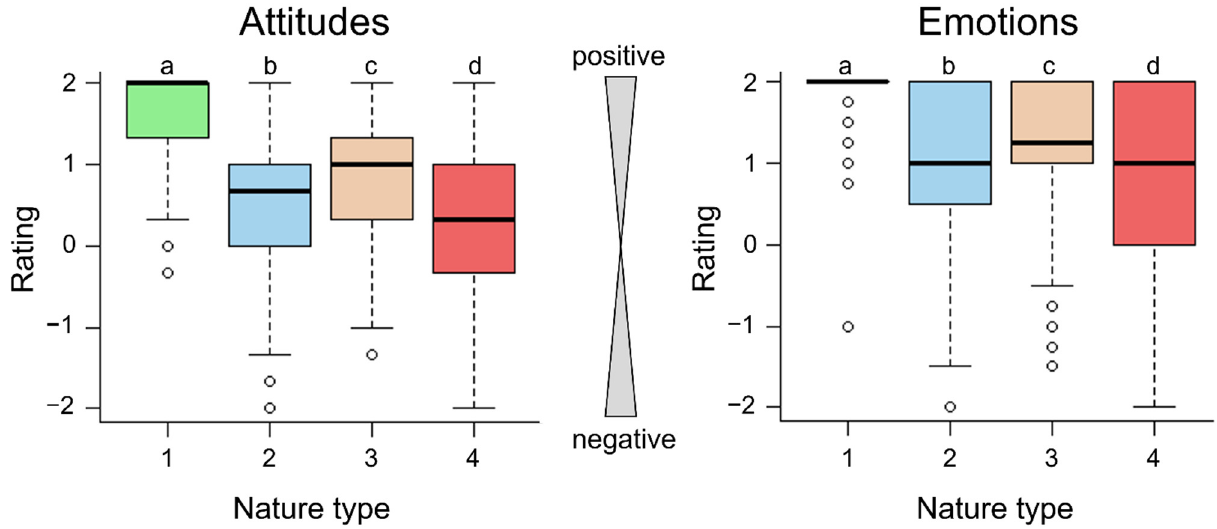
Figure 2. Respondents’ ( n = 299) attitudes and emotions towards four forest types shown in Figure 1 and representing four nature types according to the four natures concept [42,43]; see Table 3 for parameters related to attitudes and emotions. The letters a to d indicate significant differences (post-hoc pairwise Wilcoxon rank sum tests: for attitudes p < 0.001 for a to b, a to c, a to d and c to d; p < 0.01 for b to c and b to d and for emotions p < 0.001 for a to b, a to c, a to d, b to d and c to d; p < 0.01 for b to c). The left boxplot shows the respondents’ attitudes towards the four types of nature plotted on the x -axis. Correspondingly, the emotions of the participants towards the four natures are shown in the right boxplot. The values − 2 to +2 plotted on the y -axis correspond to a negative attitude or emotion ( − 2) to a positive attitude or emotion (+2).